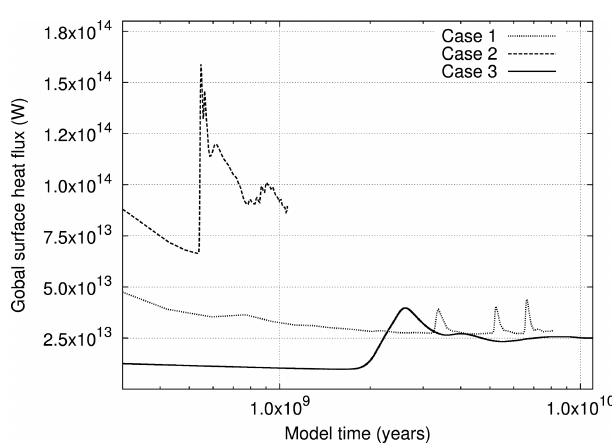
Figure 1. Model surface heat flux time series for the three cases presented, truncated to exclude variations as the model stabilizes the initial condition. The surface heat flux magnitude variations and timing offsets are the result of the varying vigour of